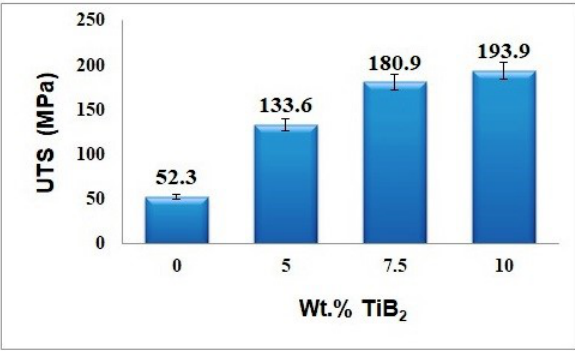
Figure 5: Ultimate Tensile Strength for AA7010 before and after addition of TiB 2 Reinforcement